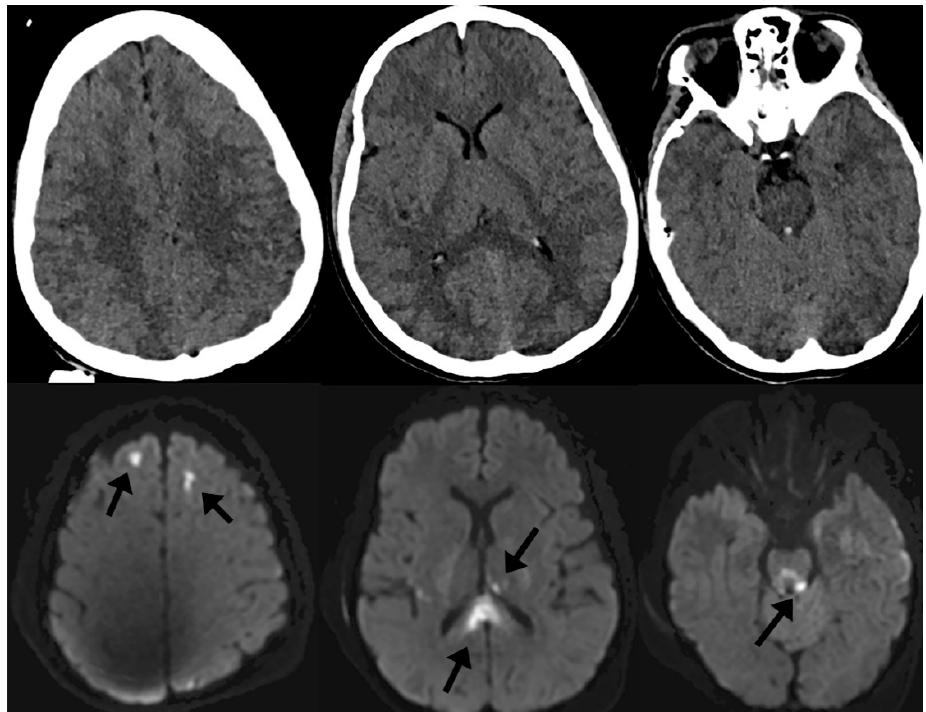
Figure 1. Noncontrast computed tomography (CT) of the head (top row) and diffusion-weighted imaging (DWI) of the brain (bottom row) of the same patient after traumatic brain injury (TBI). Imaging markers of diffuse axonal injury (DAI) include microhemorrhages on susceptibility-weighted imaging (SWI) as well as focal areas of cytotoxic edema on DWI (arrows) that are not visible on CT.